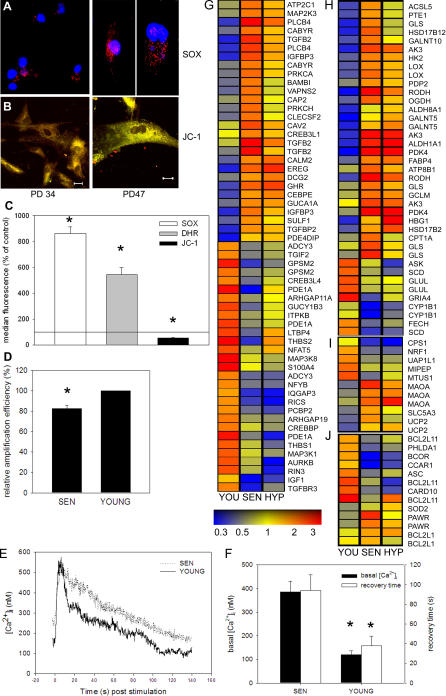
Mitochondrial Dysfunction and Retrograde Response in Senescent Cells(A) and (B) Confocal images of actively proliferating (PD 34) and senescent (PD 47) MRC-5 fibroblasts. (A) Red MitoSOX fluorescence indicates mitochondrial superoxide. Blue: DAPI. Note lower average red fluorescence and cell-to-cell heterogeneity in proliferating cultures. (B) JC-1 ratio images. A shift from red to green fluorescence indicates low MMP.(C) MitoSOX, DHR, and JC-1 ratio intensities in senescent MRC-5 fibroblasts as measured by FACS (percentage of young fibroblast control, set to 100%). Data are mean ± s.e.m., n = 3. An asterisk (*) indicates a significant difference to young controls with p < 0.001.(D) Integrity of mtDNA as measured by the relative amplification efficiency for an 11-kb mtDNA fragment in young and senescent MRC5 cells. Data are mean ± s.e.m. An asterisk (*) indicates a significant difference to young controls with p < 0.001.(E) Single cell traces of cytoplasmic calcium levels [Ca2+]i following a challenge with 100 mM CaCl2 as measured by Fluo3 fluorescence confocal imaging.(F) Basal cytoplasmic [Ca2+]i levels and recovery times in young and senescent cells. Data are mean ± s.e.m. from 13 young and 8 senescent cells. An asterisk (*) indicates a significant difference between young and senescent cells with p < 0.001.(G–J) Relative mRNA expression levels in young (YOU), senescent (SEN), and hyperoxia-treated (HYP) MRC5 (averages of two [HYP] to four [YOU] independent experiments per condition). Fold-change colour code is indicated on the bottom. For some genes, the arrays contained probe sets resulting in multiple occurrences. All genes showing at least a 2-fold expression difference between YOU and SEN were selected if the expression difference was confirmed in HYP and if they fell into one of the following categories: (G) Ca-dependent signalling; (H) glycolysis and Krebs cycle; (I) mitochondrial function and biogenesis; and (J) stress response and apoptosis.